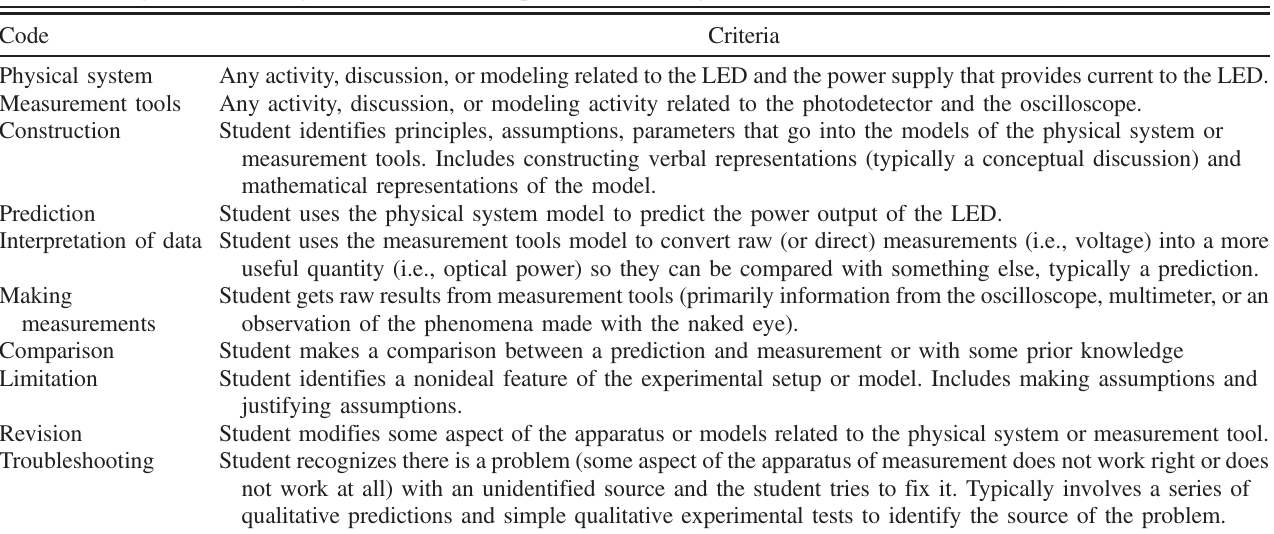
TABLE I. High-level modeling codes and brief descriptions of the coding criteria for the think-aloud lab activity discussed in Sec.